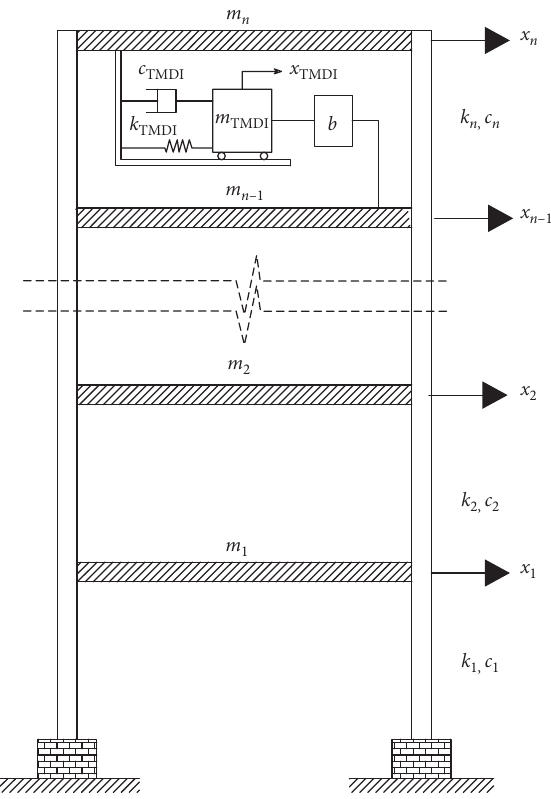
Figure 2: n degrees of freedom system equipped with a TMDI